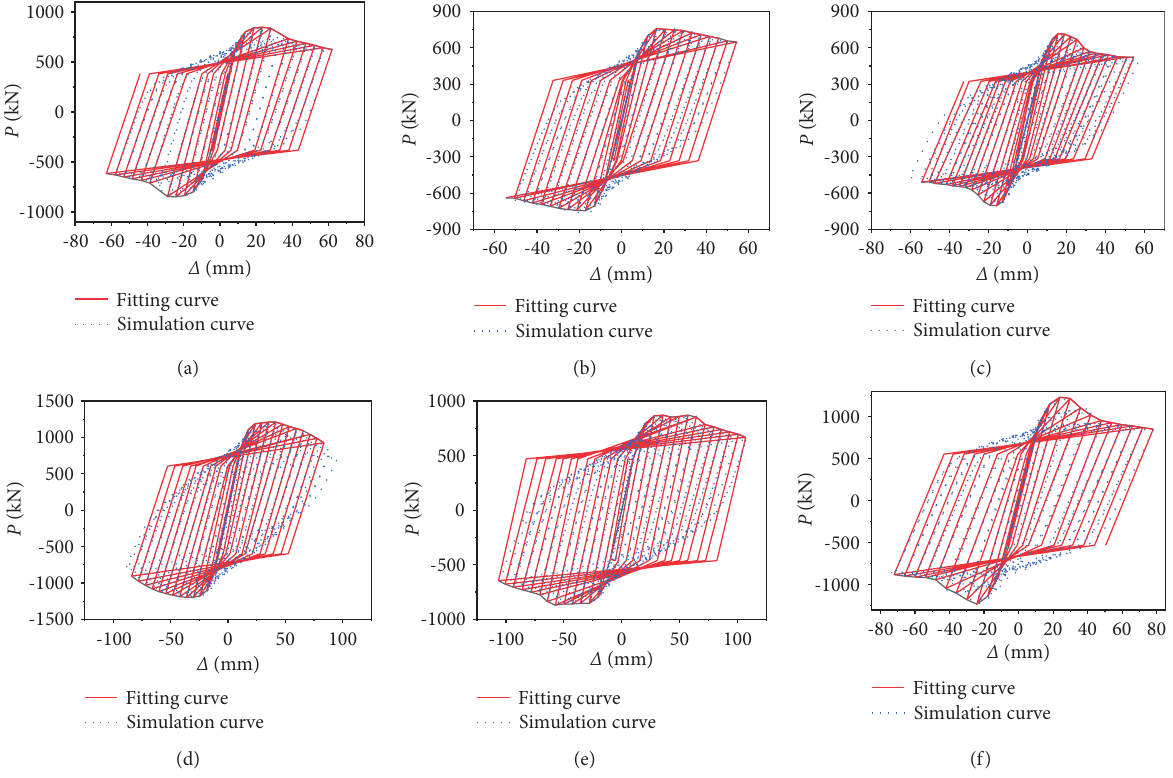
Figure 25: Comparisons of hysteresis curves between calculation and simulation. (a) STHCC5. (b) STHCC8. (c) STHCC12. (d) STHCC16. (e) STHCC17. (f)